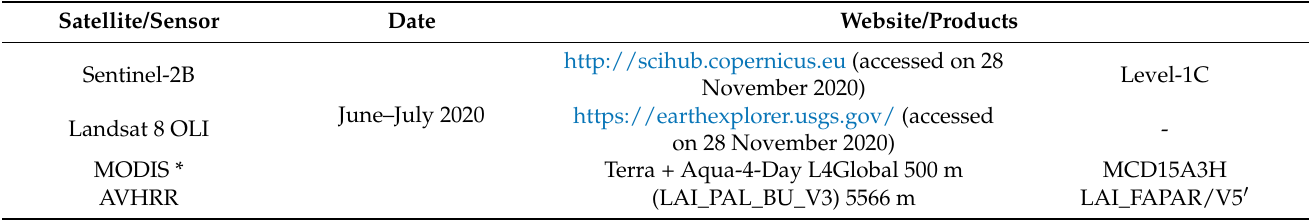
Table 2. Selected satellite images and